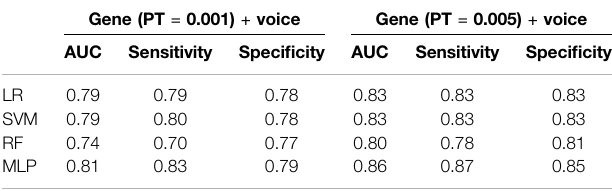
TABLE 2 | Classi fi cation results using different machine learning (ML) models Gene (PT = 0.001) + voice